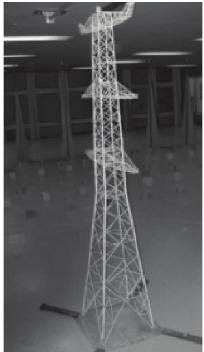
Figure 8: Scheme of the field